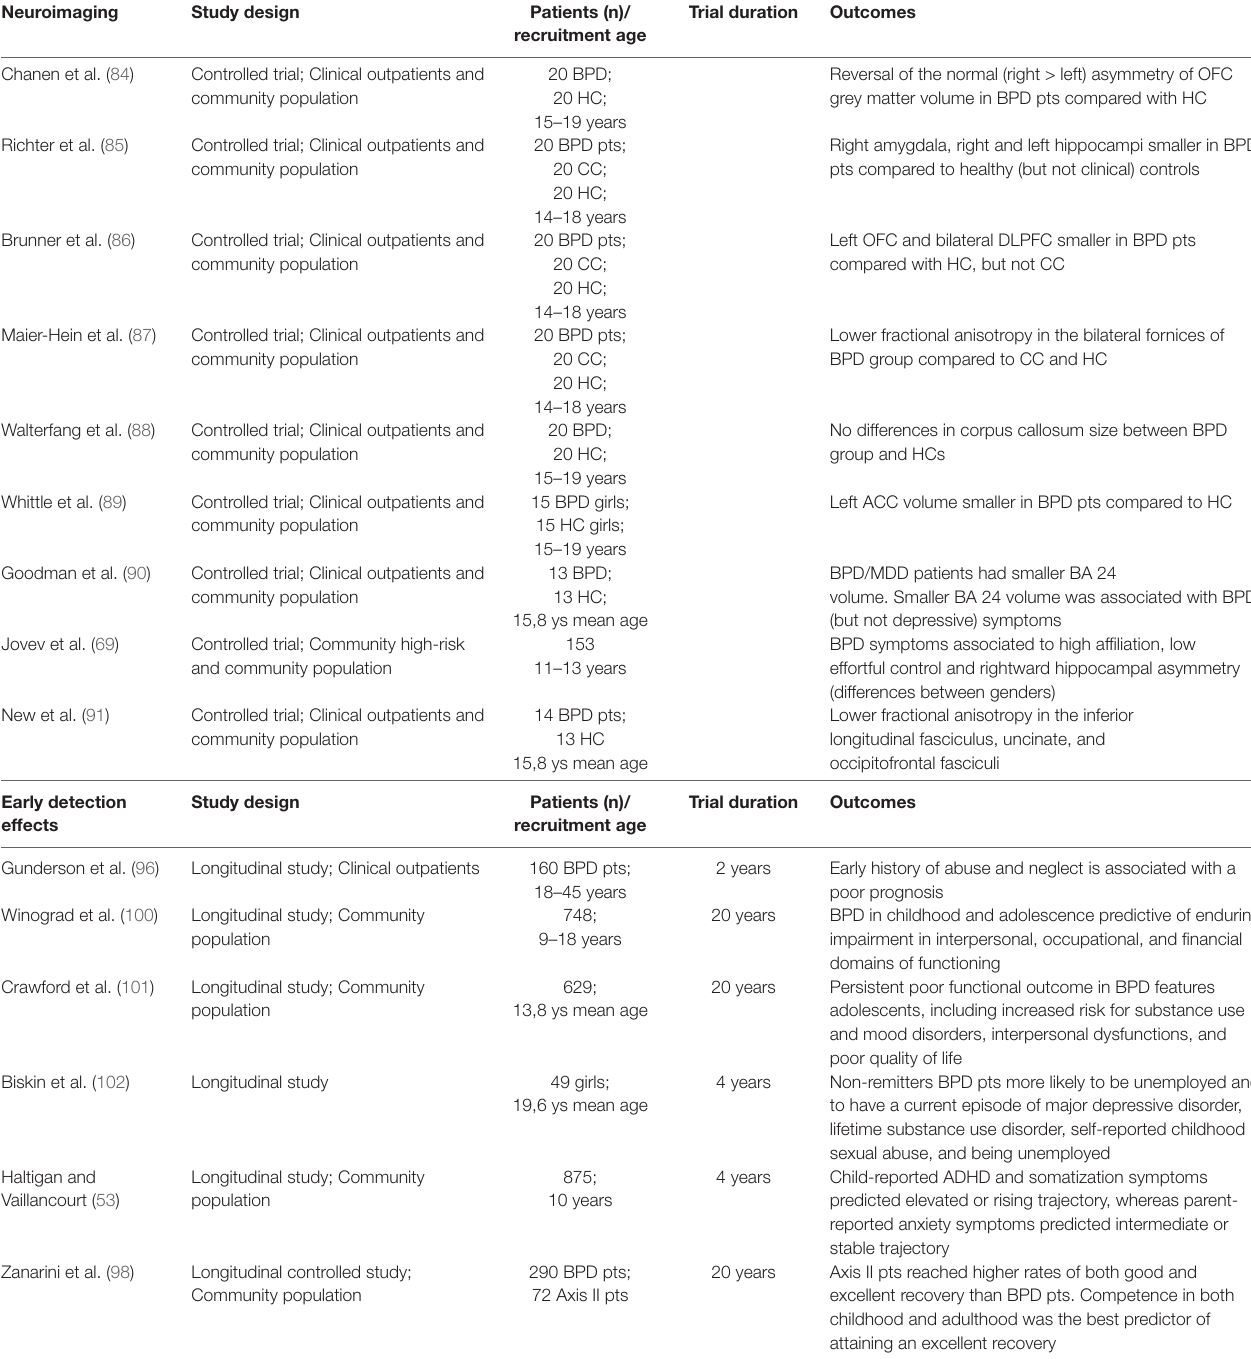
TABLE 3 | Summary of studies on neuroimaging and effect of early detection on course and outcome of BPD.